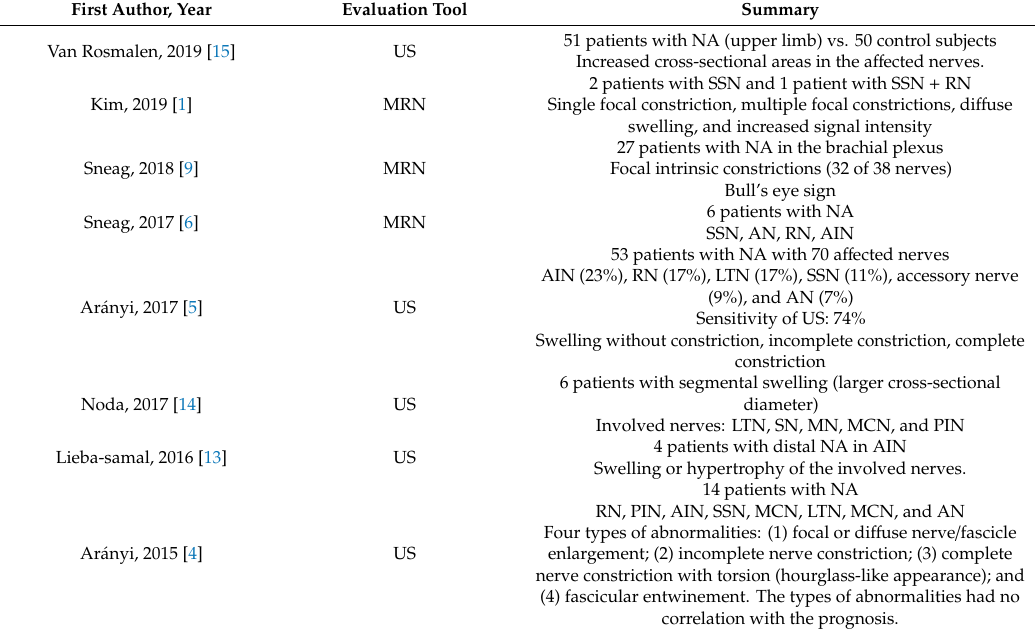
Table 1. Summary of the previous studies on findings of magnetic resonance neurography or ultrasound of hourglass-like constriction neuropathy or neuralgic